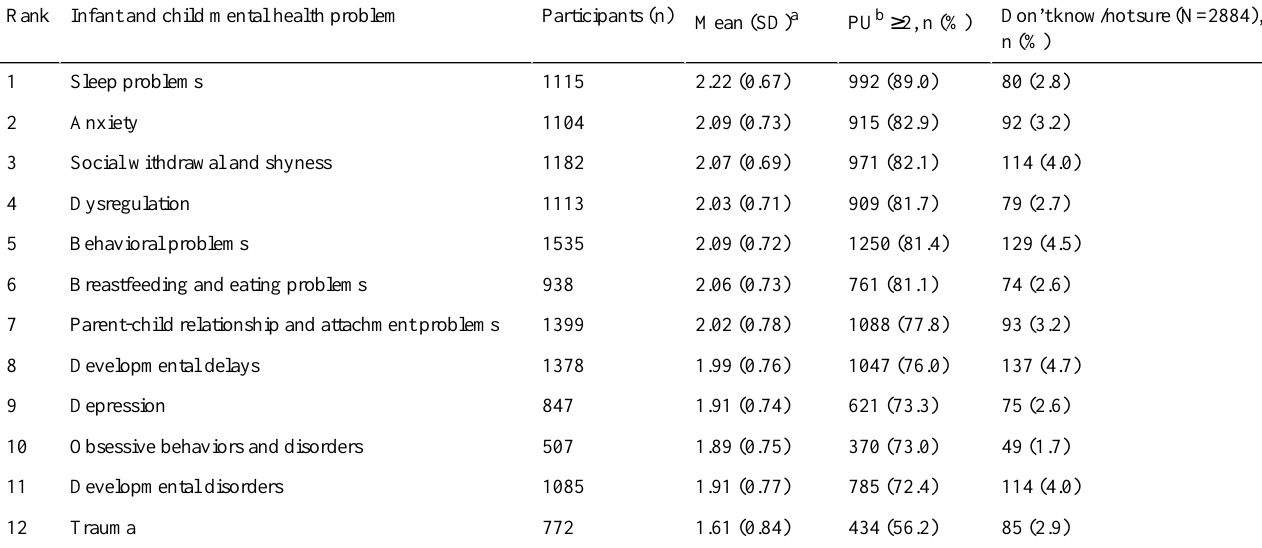
Table 2. Overall ranking of the perceived usefulness of internet-based programs for infant and child mental health problems.